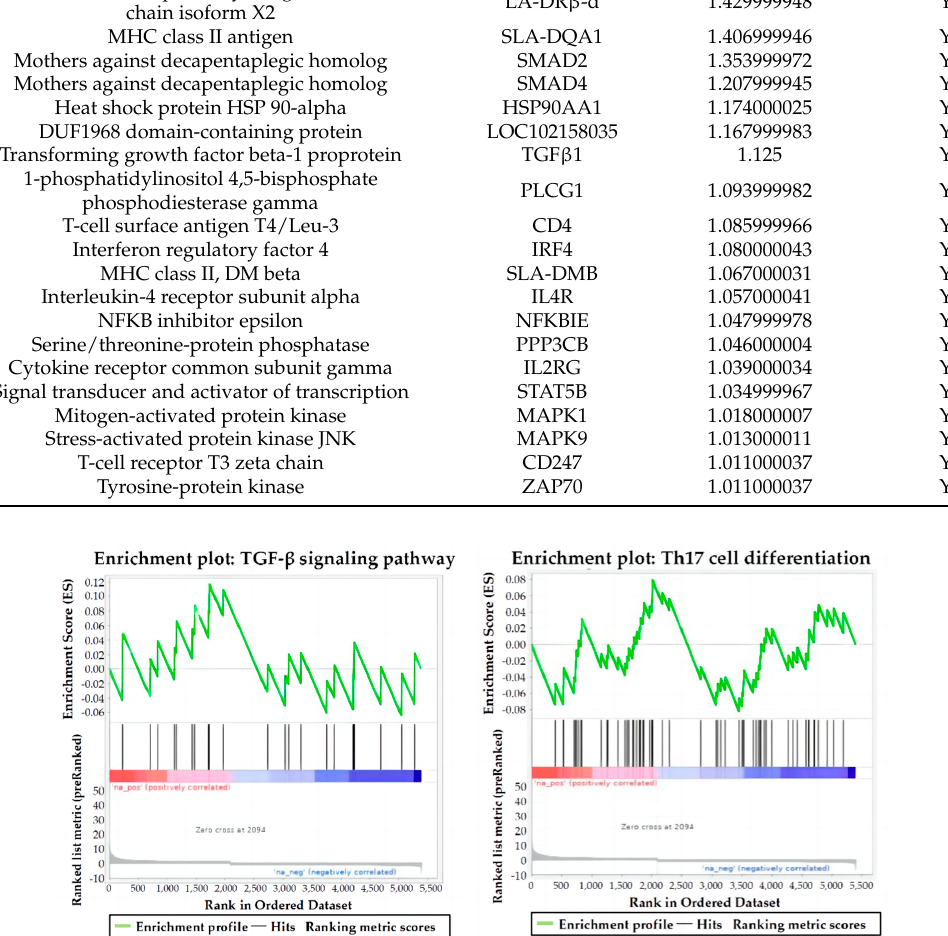
Table 2. Core proteins that inhibited the differentiation of Th17 cells.